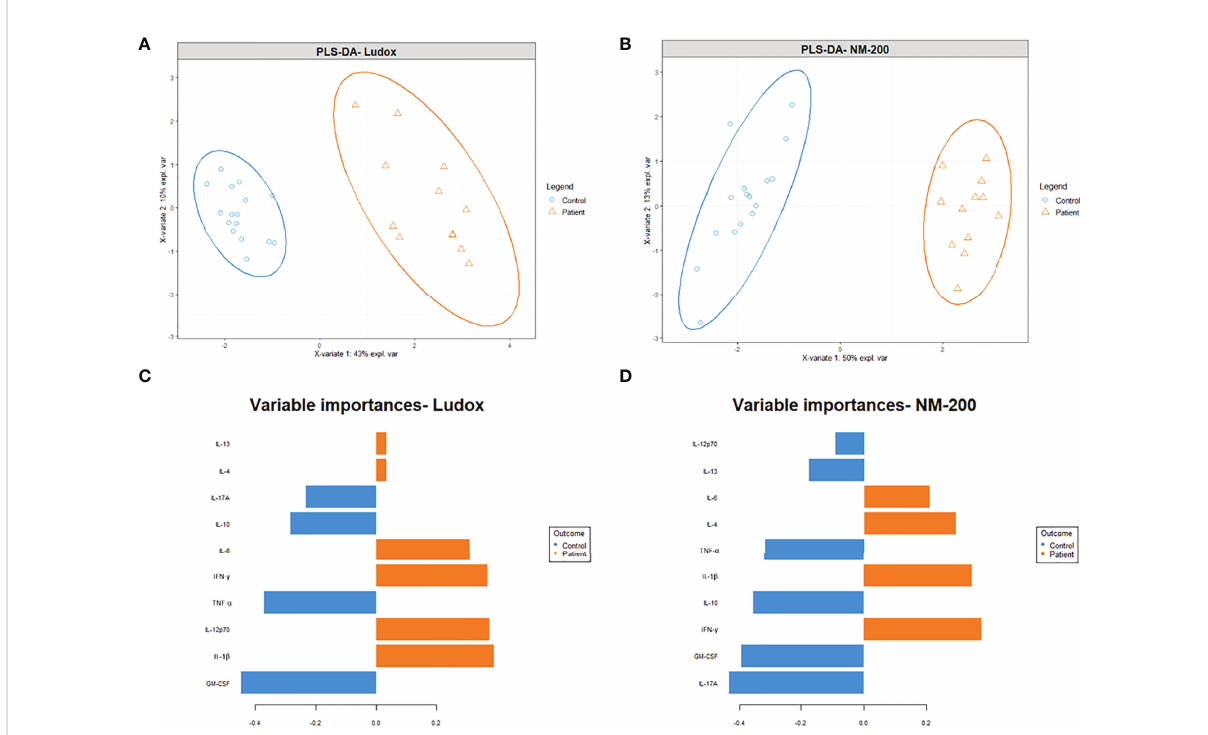
FIGURE 7 (A – D) Projection of multi-cytokine data to identify for differences in cytokine pro fi les between patients and controls. A partial least squares discriminant analysis (PLS-DA) plot was made with the log 10 transformed, centered, and scaled multi-cytokine data between patients and controls on day 7. Strong differing pro fi les between patients and controls were noted with Ludox (A) and NM-200 (B) stimulation. A variable/ cytokine importance plot for Ludox (C) and NM-200 (D) stimulation were also made to show the degree at which individual cytokines contribute towards the differences in the outcome/